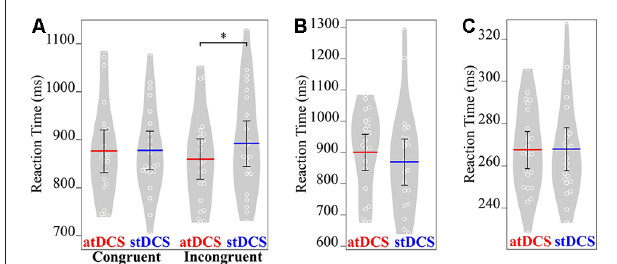
FIGURE 3 | Mean RT (in ms) of the three tasks under both atDCS and stDCS. (A) Gestural task for congruent and incongruent stimuli. Only for incongruent stimuli, RT was significantly faster under atDCS compared to stDCS. (B) Attentional load and (C) simple RT task showed no significant difference in RT in atDCS compared to stDCS. Plots were constructed using BoxPlotR (Spitzer et al., 2014; http://shiny.chemgrid.org/boxplotr/). The white circles represent the individual data points, the red and blue lines represent the mean values across the group. Error bars represent 95% confidence interval. Violin plots show the distribution across subjects. ∗ p < 0.05.